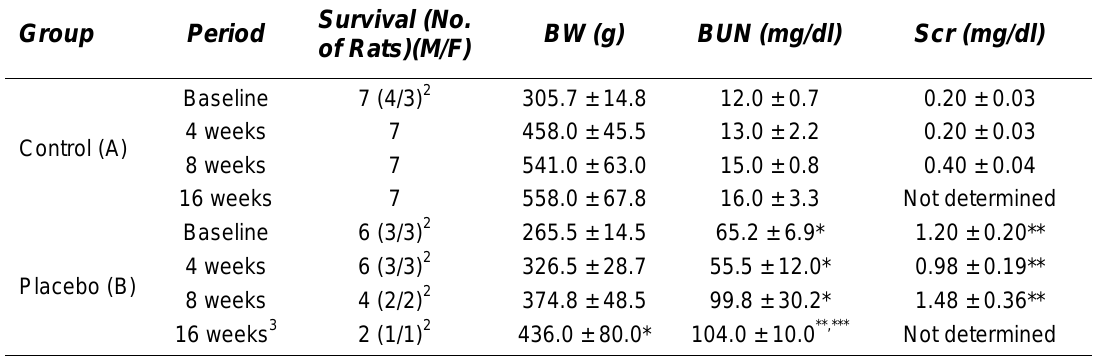
Comparison of Survival, BW, BUN, and Scr Concentrations of Control Rats and Placebo 1